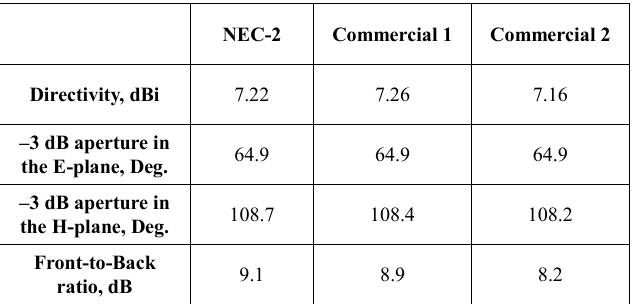
Fig. 11. Comparison of the results obtained by OpenEMS, nec2c, and a commercial code. Feeding point impedance of the BiQuad antenna. Red line: